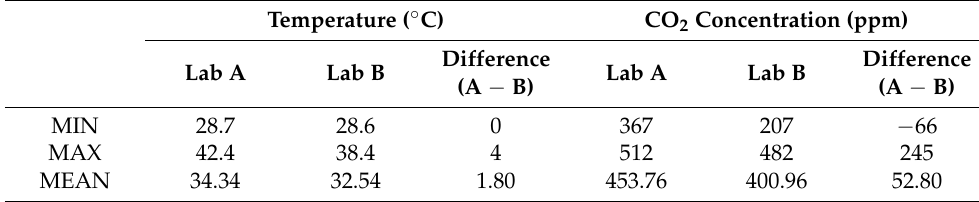
Table 6. Comparison of Experiment 1.